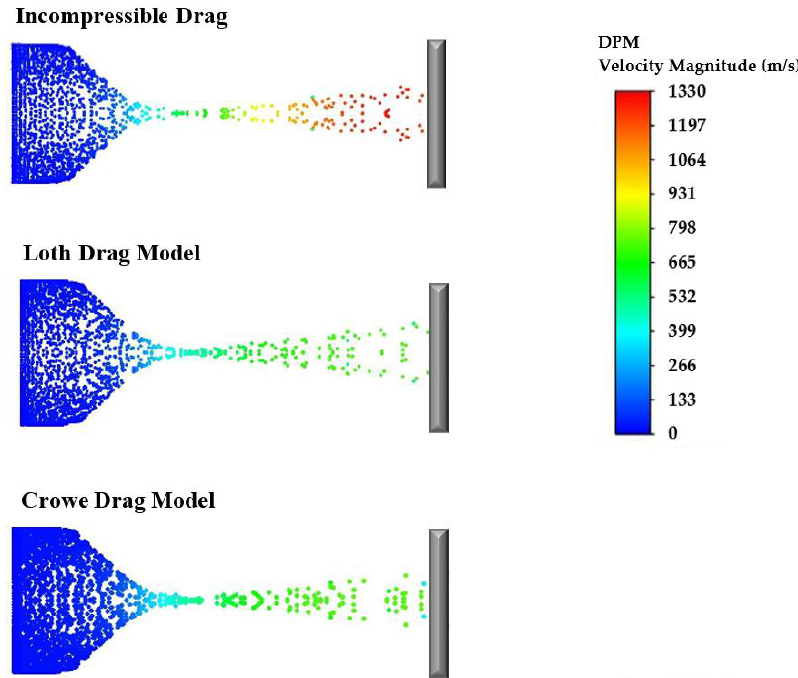
Figure 14. Effect of drag coefficients on particle velocity, d p = 1 µ m.